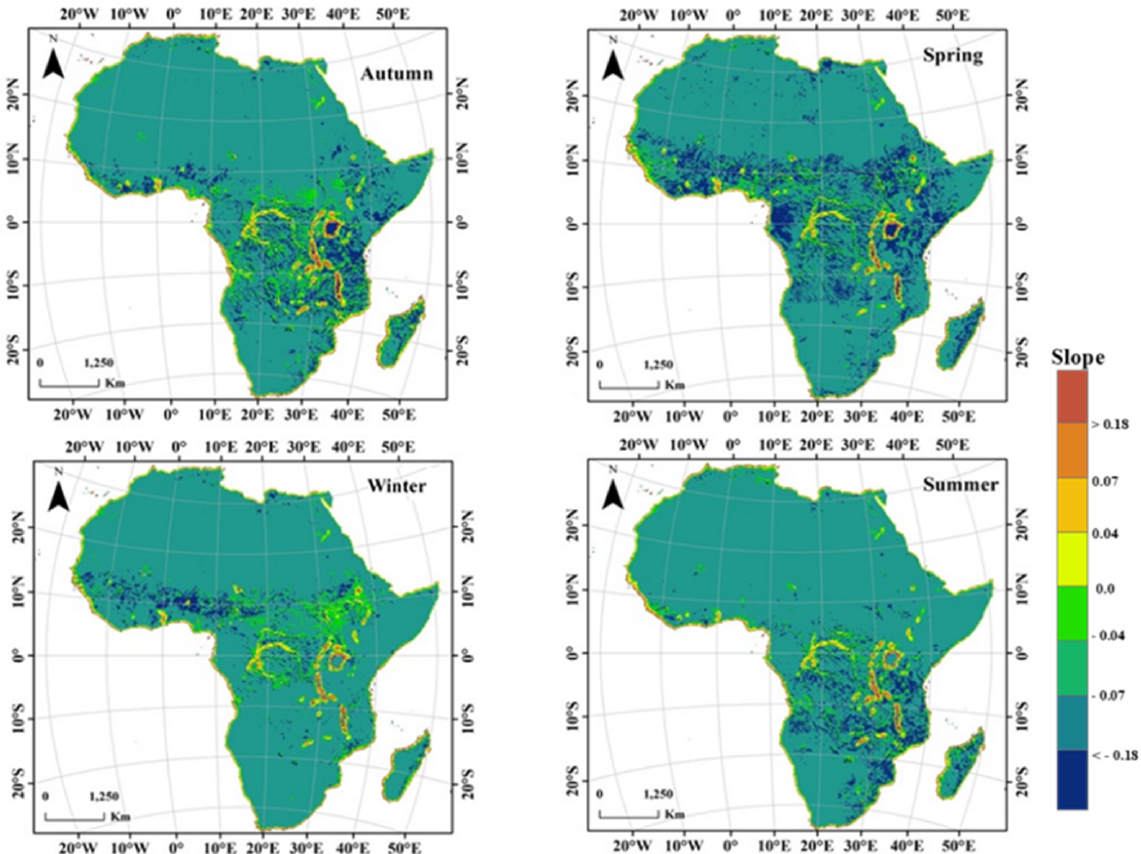
Figure 7. The slope of seasonal soil moisture change from 2003 to 2017.